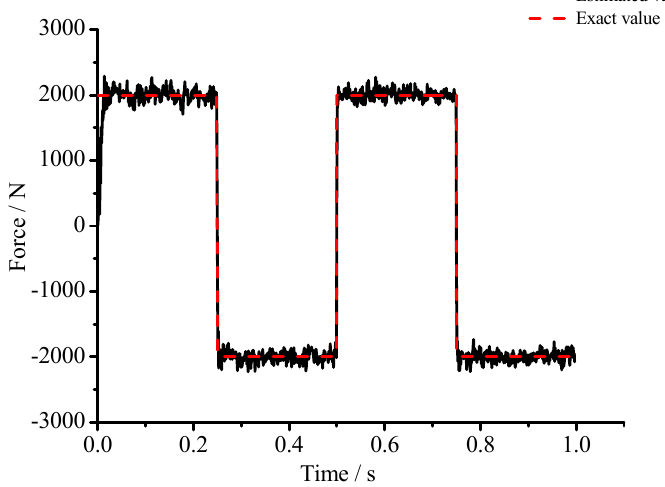
Figure 7. Estimation results of the rectangular input force ( Q w = 1 × 10 − 4 , σ = 1 × 10 − 8 ) . Materials 2017 , 10 , 1162